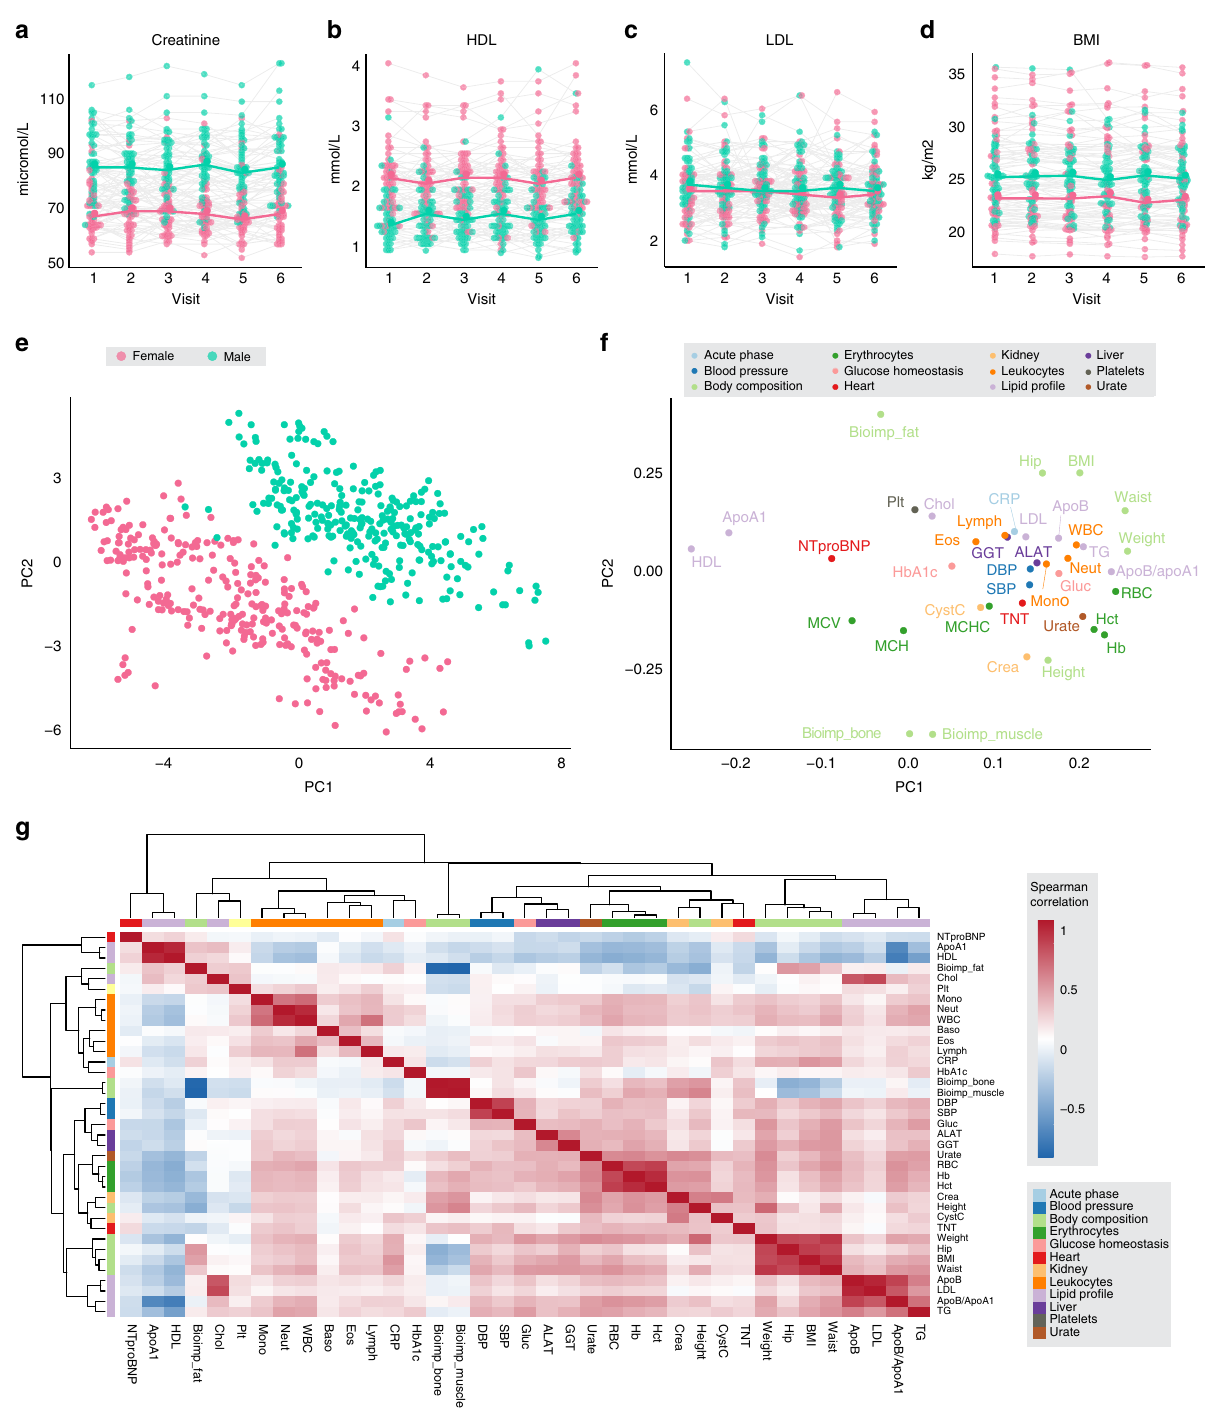
Fig. 2 Clinical chemistry and anthropometrics longitudinal variation. Clinical chemistry variation across the six visits for 94 subjects in: a Creatinine, b high- density lipoproteins (HDL), c low-density lipoproteins (LDL), as well as the variation in d body mass index (BMI). The color indicates males and females, the colored lines visualize the medians for each visit and sex respectively, and each individual is connected by a gray line. Principal Component Analysis (PCA) based on data from visits 1 – 6 for 41 parameters including anthropometrics, clinical chemistry and hematology variables is visualized as e scores plot showing clear separation between males and females and f loadings plot showing the relationship between the underlying variables (Explained variance: PC1 = 23%, PC 2 = 13%). g Heatmap showing the pairwise Spearman correlations between 37 clinical chemistry and anthropometry